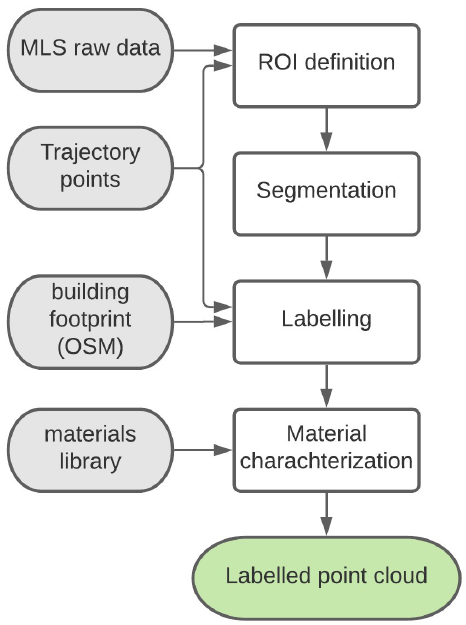
Figure 1. Flowchart explaining the method presented in this paper.